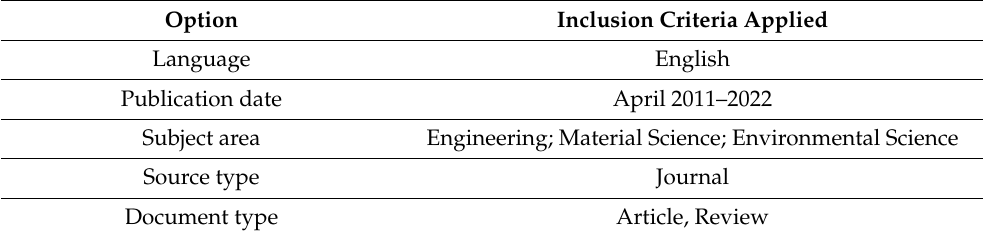
Table 1. Inclusion criteria applied when retrieving data from Scopus as of 25 April 2022.